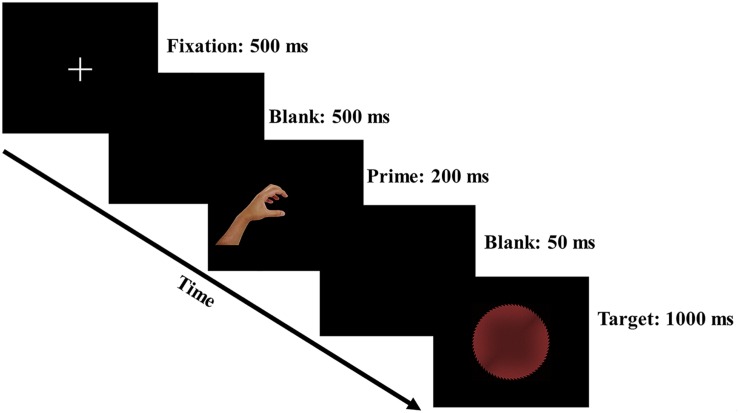
Schematic representation of the trial procedure.